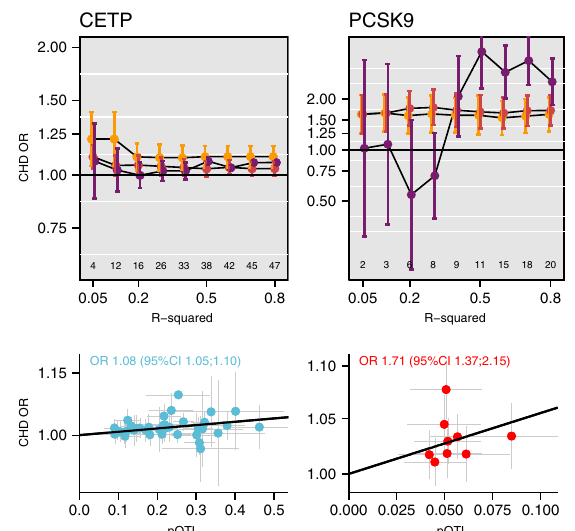
Fig. 5 Mendelian randomisation estimates of protein level effects on CHD, with a grid of LD threshold. Pairwise LD was accounted for using the 1000 genomes ‘ EUR ’ reference panel 52 and a (GLS) generalised least squares method 17 with or without Egger correction for possible horizontal pleiotropy. The number of included variants in the 1 mega base fl anking region is depicted above the x -axis of the top panels. Estimates are given as OR with 95%CI (vertical error bars). The top panel depicts the variant to CHD or protein level effect for clumping threshold 0.5 for CETP (based on an Egger correct GLS model), and at 0.4 for PCSK9 using an IVW GLS model; 38 and 9 variants, respectively. Notice that the PCSK9 estimates were only available on the natural logarithmic